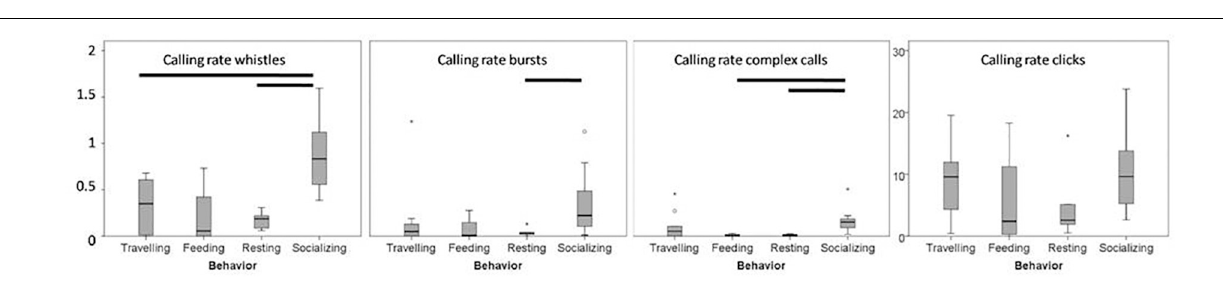
FIGURE 4 | Box plots of the values of the calling rate of the vocalizations in relation to the different activity classes. Black bars represent significant variations between behaviors. The y scale of the whistles calling rate is the same for whistles, bursts and complex